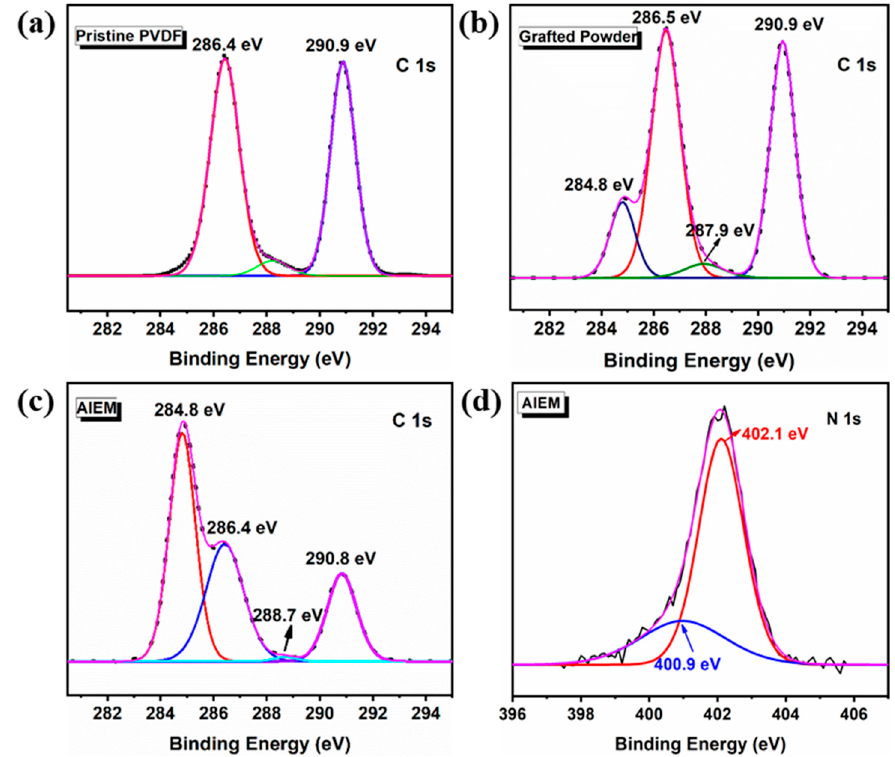
Figure 7. Fitted C 1s XPS spectra of ( a ) pristine PVDF, ( b ) grafted powder, and ( c ) AIEM and ( d ) N 1s spectrum of AIEM (GY = 28.4%).